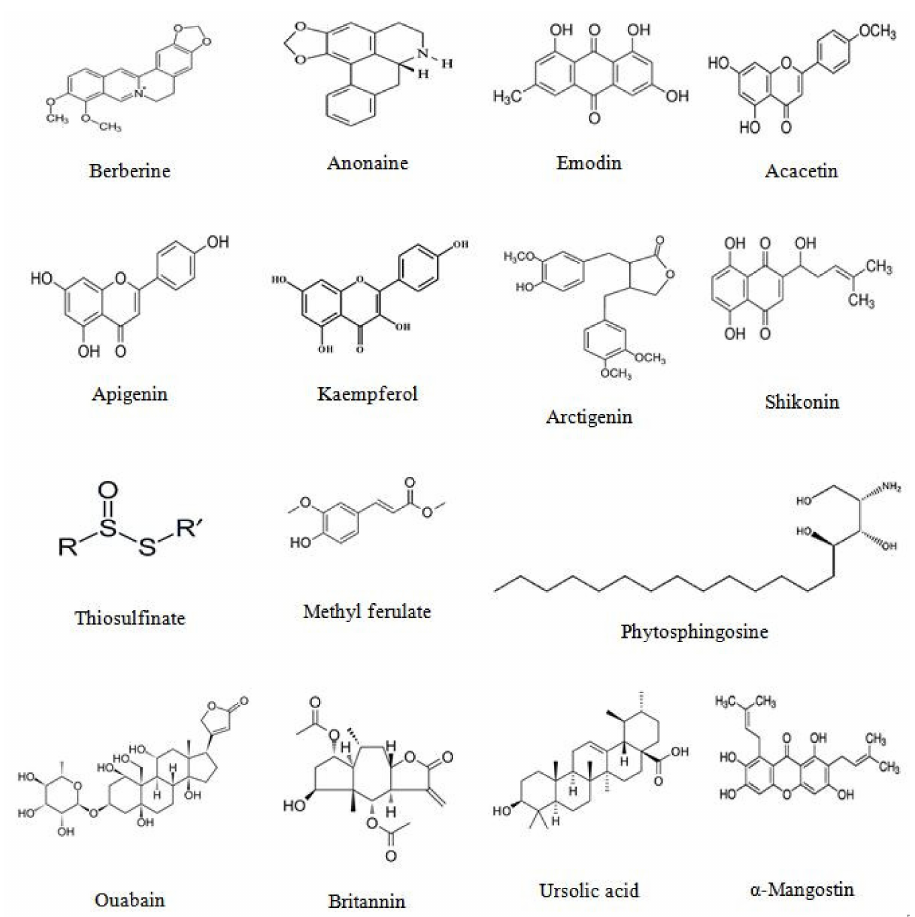
Figure 4. The chemical structure of some major examples of phytochemicals with proapoptotic